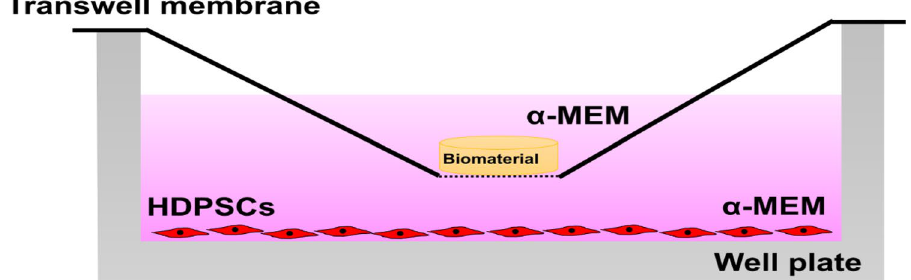
Figure 8. Positioning of biomaterial in the transwell membrane without direct contact with